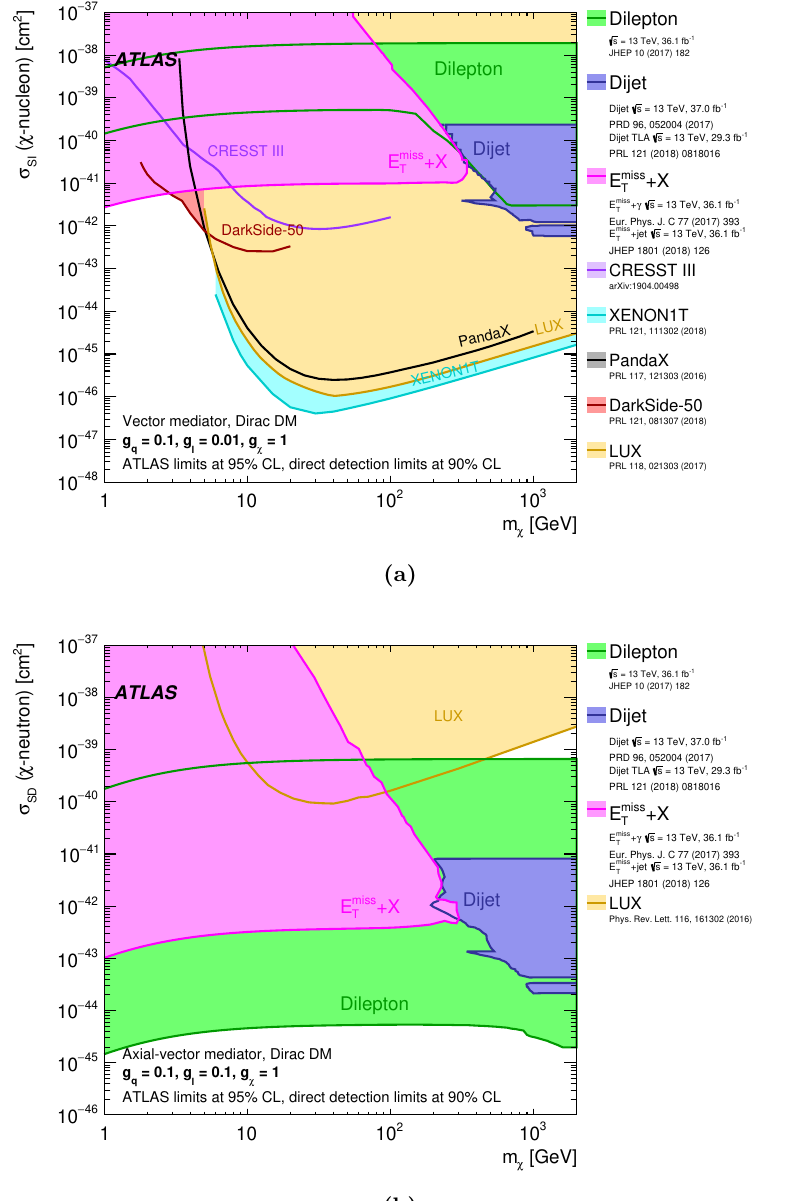
Figure 25. A comparison of the inferred limits with the constraints from direct detection exper- iments on the spin-independent WIMP-nucleon (spin-dependent WIMP-neutron) scattering cross- section in the context of (a) the Z 0 -like simpli(cid:12)ed model with leptophilic vector or (b) axial-vector couplings. The results from this analysis, excluding the region to the left of the contour, are com- pared with limits from the direct detection experiments. LHC limits are shown at 95% CL and direct detection limits at 90% CL. The comparison is valid solely in the context of this model, assuming a mediator width (cid:12)xed by the dark matter mass and the coupling values highlighted in each (cid:12)gure. LHC searches and direct detection experiments exclude the shaded areas. Exclusions of smaller scat- tering cross-sections do not imply that larger scattering cross-sections are also excluded. The reso- nance and E miss +X exclusion region represents the union of exclusions from all analyses of that type. T